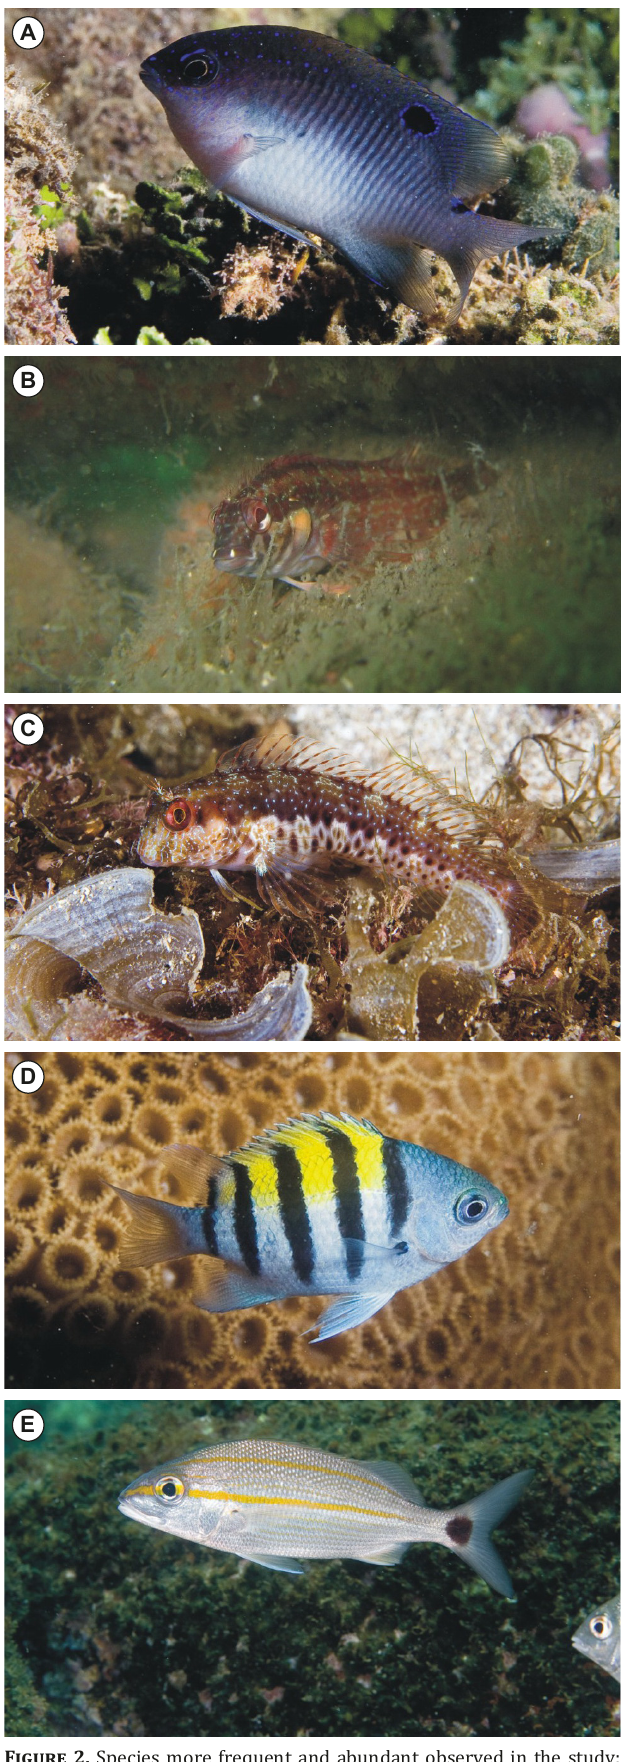
Stegastes fuscus Malacoctenus delalandii Parablennius Species more frequent and abundant observed in the study: marmoreus Abudefduf saxatilis Haemulon aurolineatum (A) ; (B) ; (C) Anisotremus virginicus Chaetodon striatus ; (D) ; and (E) . Cleaning station observed in the Currais Archipelago. Photos A, C, D, and E by Athila Bertoncini. Photo B by Felippe Daros. and . Photo by Felippe